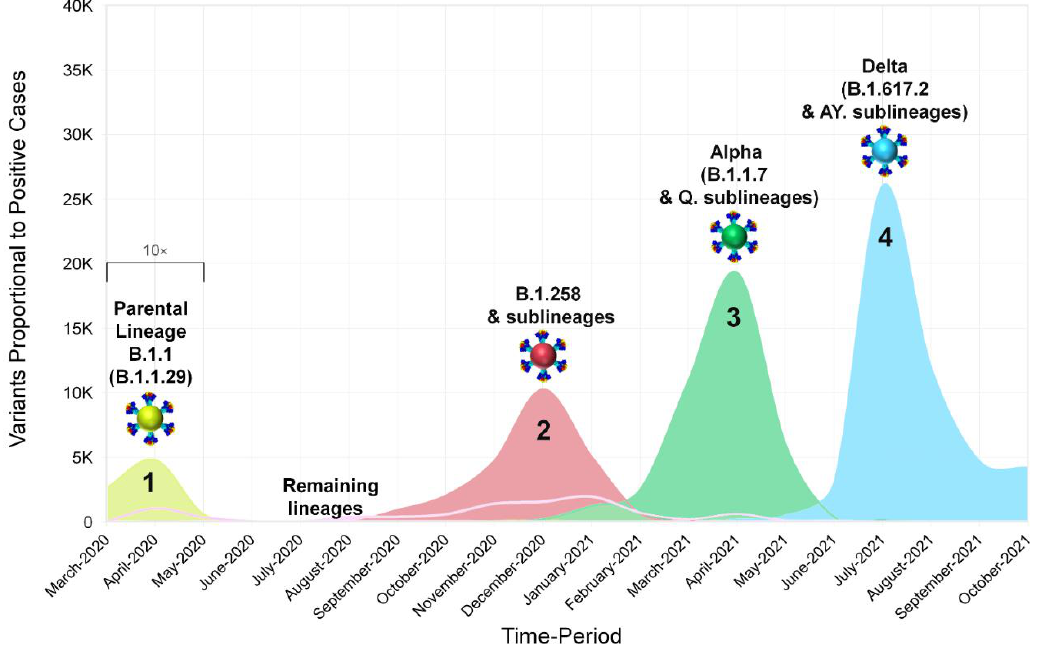
Figure 2. The progression and waves of SARS-CoV-2 infection in Cyprus from March 2020 until October 2021. Data from our previous work covering the period of April 2020 to January 2021 [29] were included for continuity purposes as well as to show the development of SARS-CoV-2 infection in Cyprus. In this figure, the number of positive SARS-CoV-2 cases per month reported in Cyprus from March 2020 until October 2021 is shown proportionally to the most prevalent SARS-CoV-2 variants (see Figure 1A,E,F). Sequences of B.1.1.29 (Parental Lineage B.1.1), B.1.258 & sublineages, Alpha (B.1.1.7 & Q. sublineages) and Delta (B.1.617.2 & AY. sublineages), and the remaining lineages, as shown in the smoothed line chart, are depicted in bright-green, red, green, light-blue, and pink, respectively. Values underneath the black bracket (March 2020 – May 2020) were multiplied by 10 to enhance their visibility.